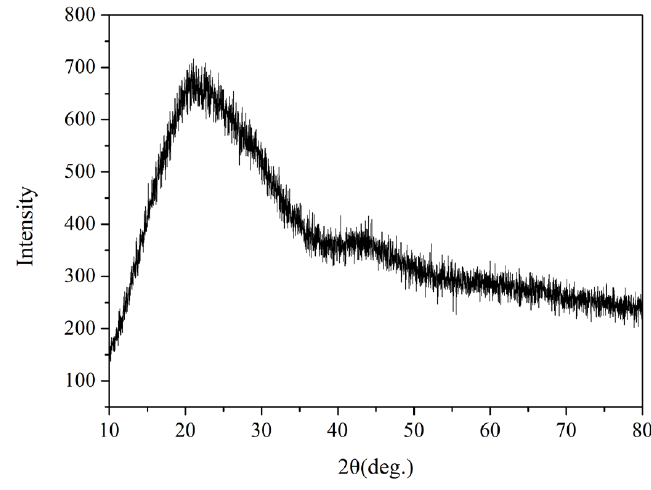
Figure 6. XRD pattern of the 6FDA-DPEDBA PI film.